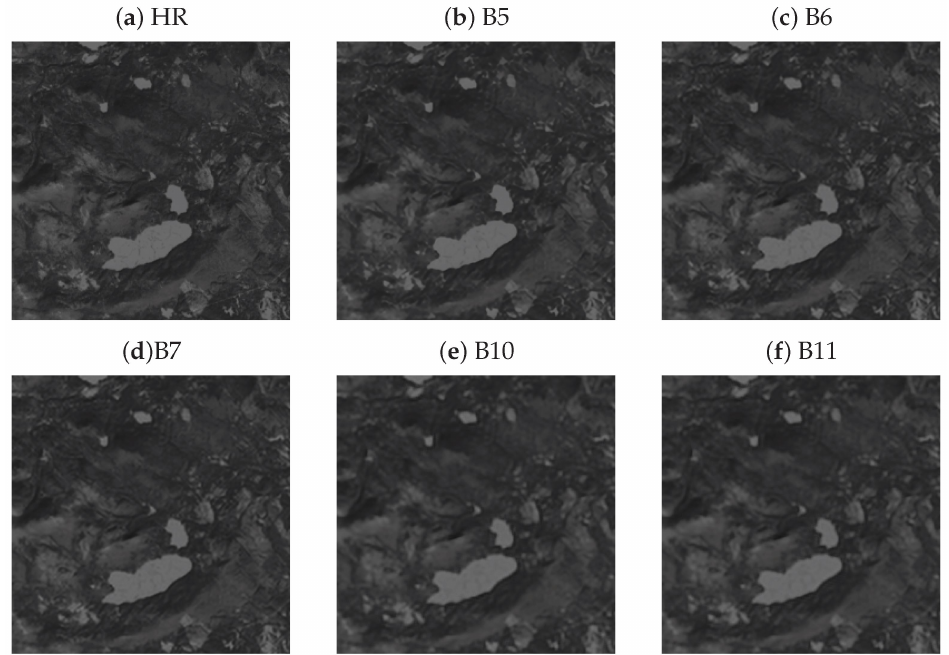
Figure 7. Visual results of B5 testing set. The titles of subfigures ( b – f ) represent the training set of SR